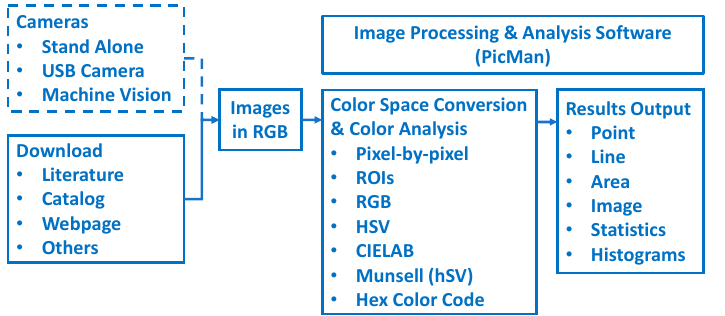
Figure 1. Block diagram from image acquisition, color space conversion, image analysis, and results output.